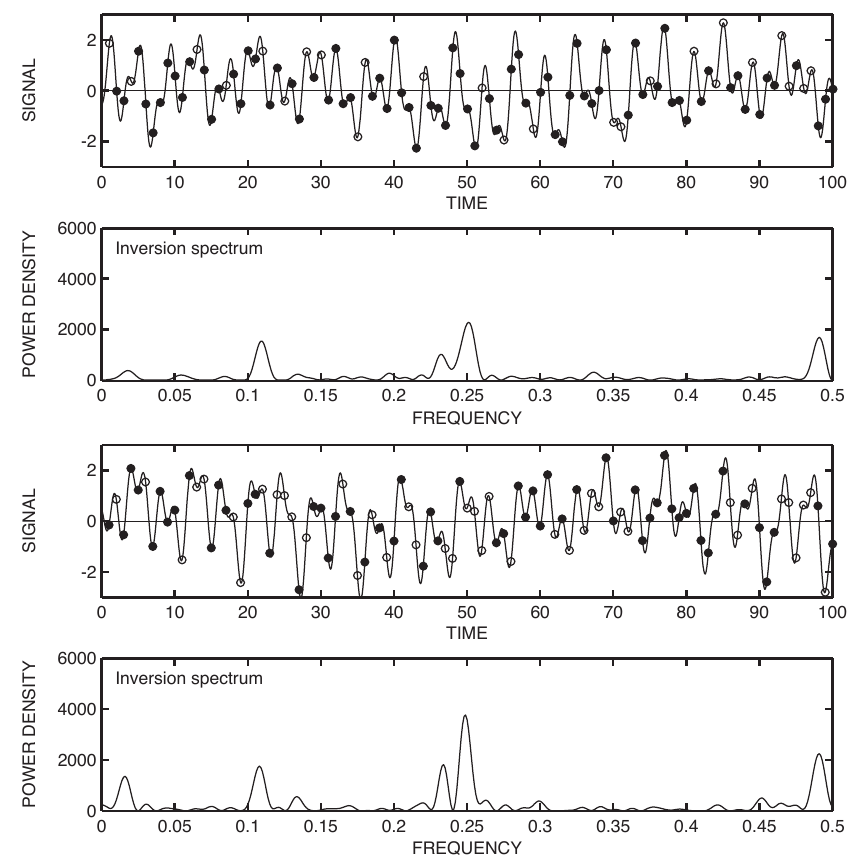
Fig. 3. Two examples similar to that in Fig. 2. The frequencies and amplitudes of the signals are the same as in Fig. 2, but the phases are different. Thus the Fourier spectra are identical and are not shown. In the first example (two top panels) the number of dropped samples is 25 and in the second example (two bottom panels)